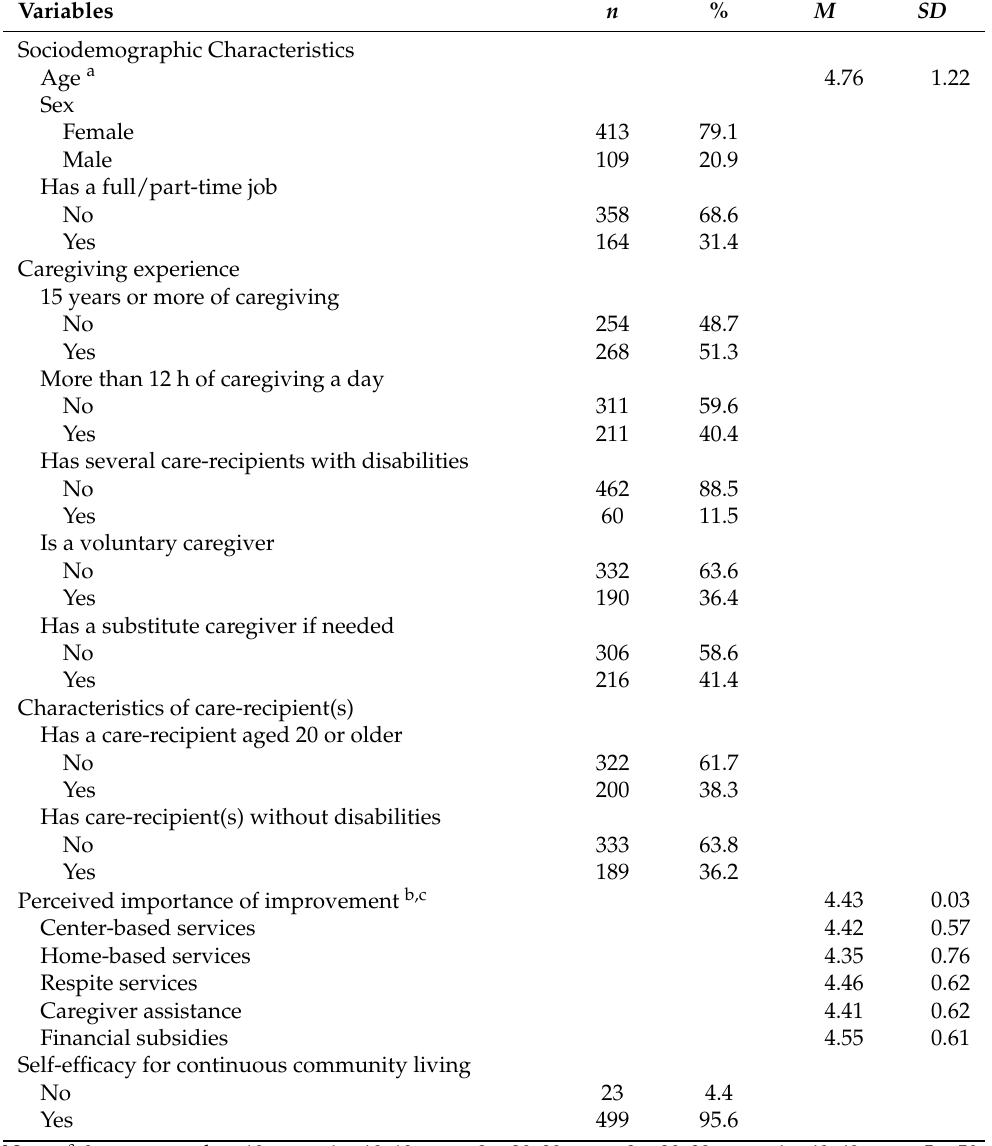
Table 1. The characteristics of caregivers in our sample ( n =